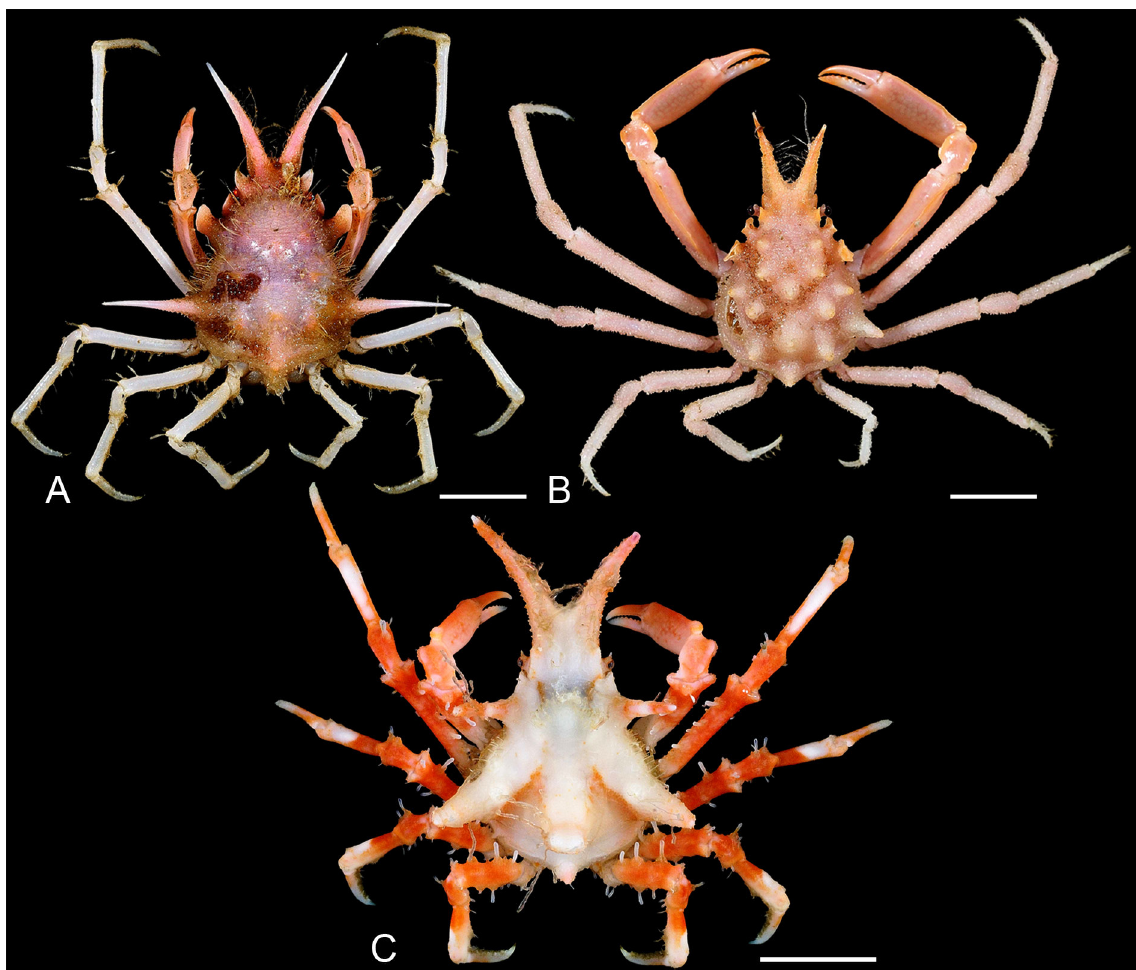
Fig. 7. Colour in life. A . Rochinia kotakae Takeda, 2001, ovigerous ♀ (14.0 × 9.1 mm) (ZRC 2016.0079), South China Sea. B . Rochinia strangeri Serène & Lohavanijaya, 1973, ♂ (12.2 × 8.0 mm) (ZRC 2016.0546), South China Sea. C . Rochinia kagoshimensis (Rathbun, 1932) comb. nov., ♂ (10.7 × 6.9 mm) (ZRC 2016.0549), South China Sea. Scale bars =